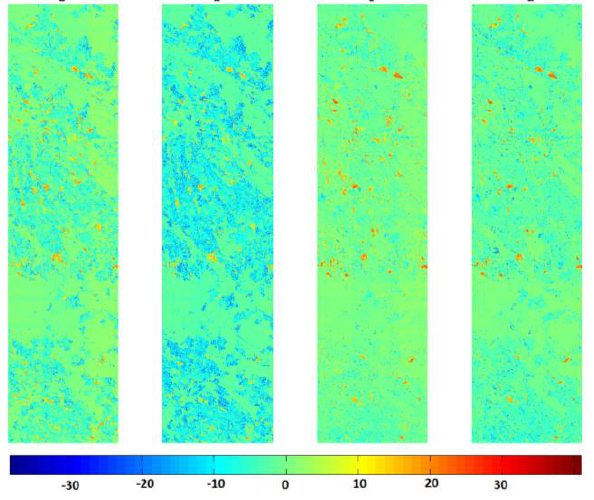
Figure 1. Difference surfaces from left: a)ALS – after-storm UMD, b) ALS – after-storm NGATE, c) pre-storm NGATE – after- storm UMD, d) pre-storm NGATE – after-storm NGATE. The colour bar at the bottom shows the height colour coding.